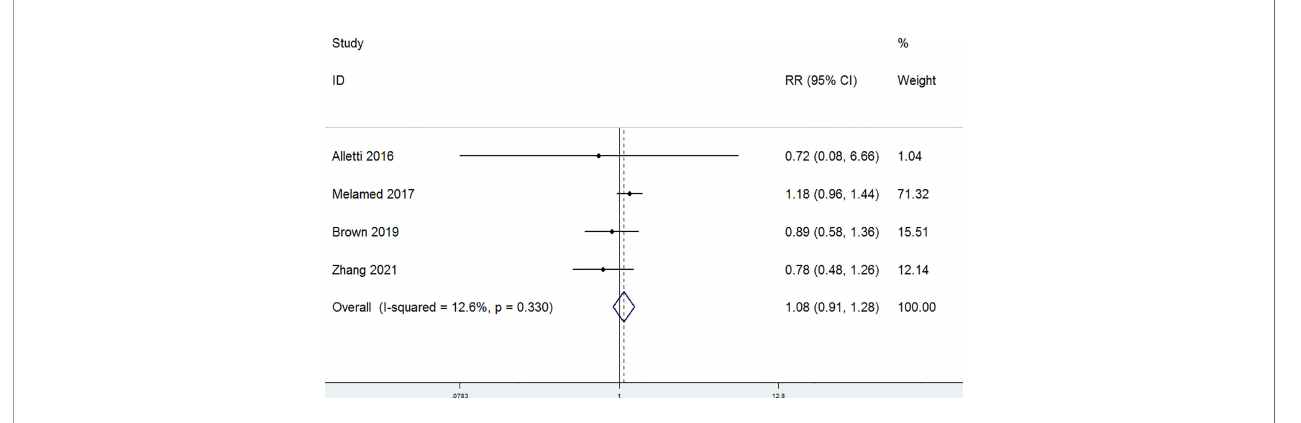
FIGURE 5 | Forest plots for residual disease ≤ 1 cm